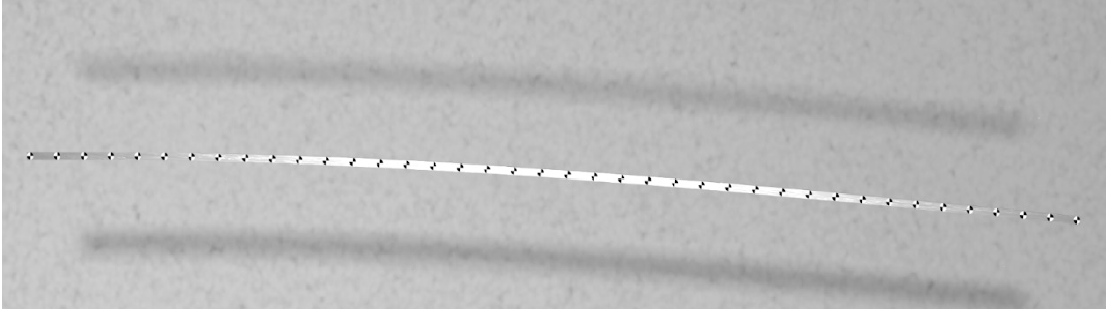
Figure 12. Render obtained for the adopted camera system.